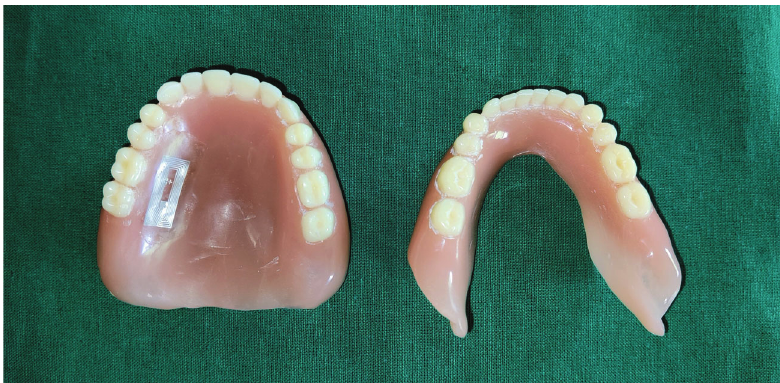
Figure 6: NFC tag incorporated into maxillary denture.